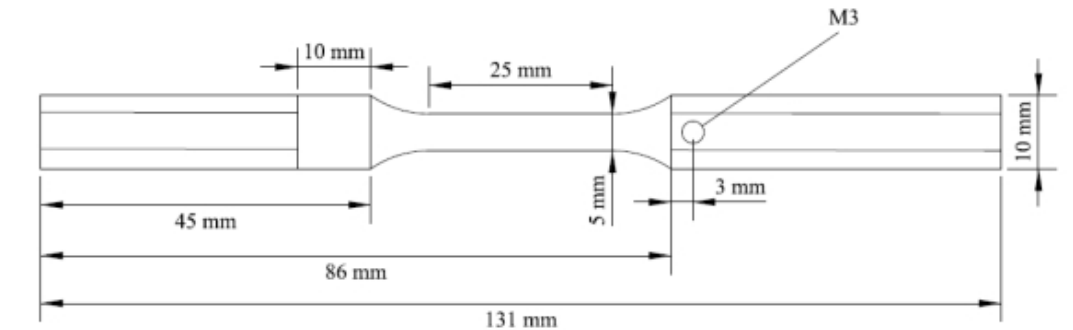
Figure 1. Schematic drawing of the SSRT specimens.